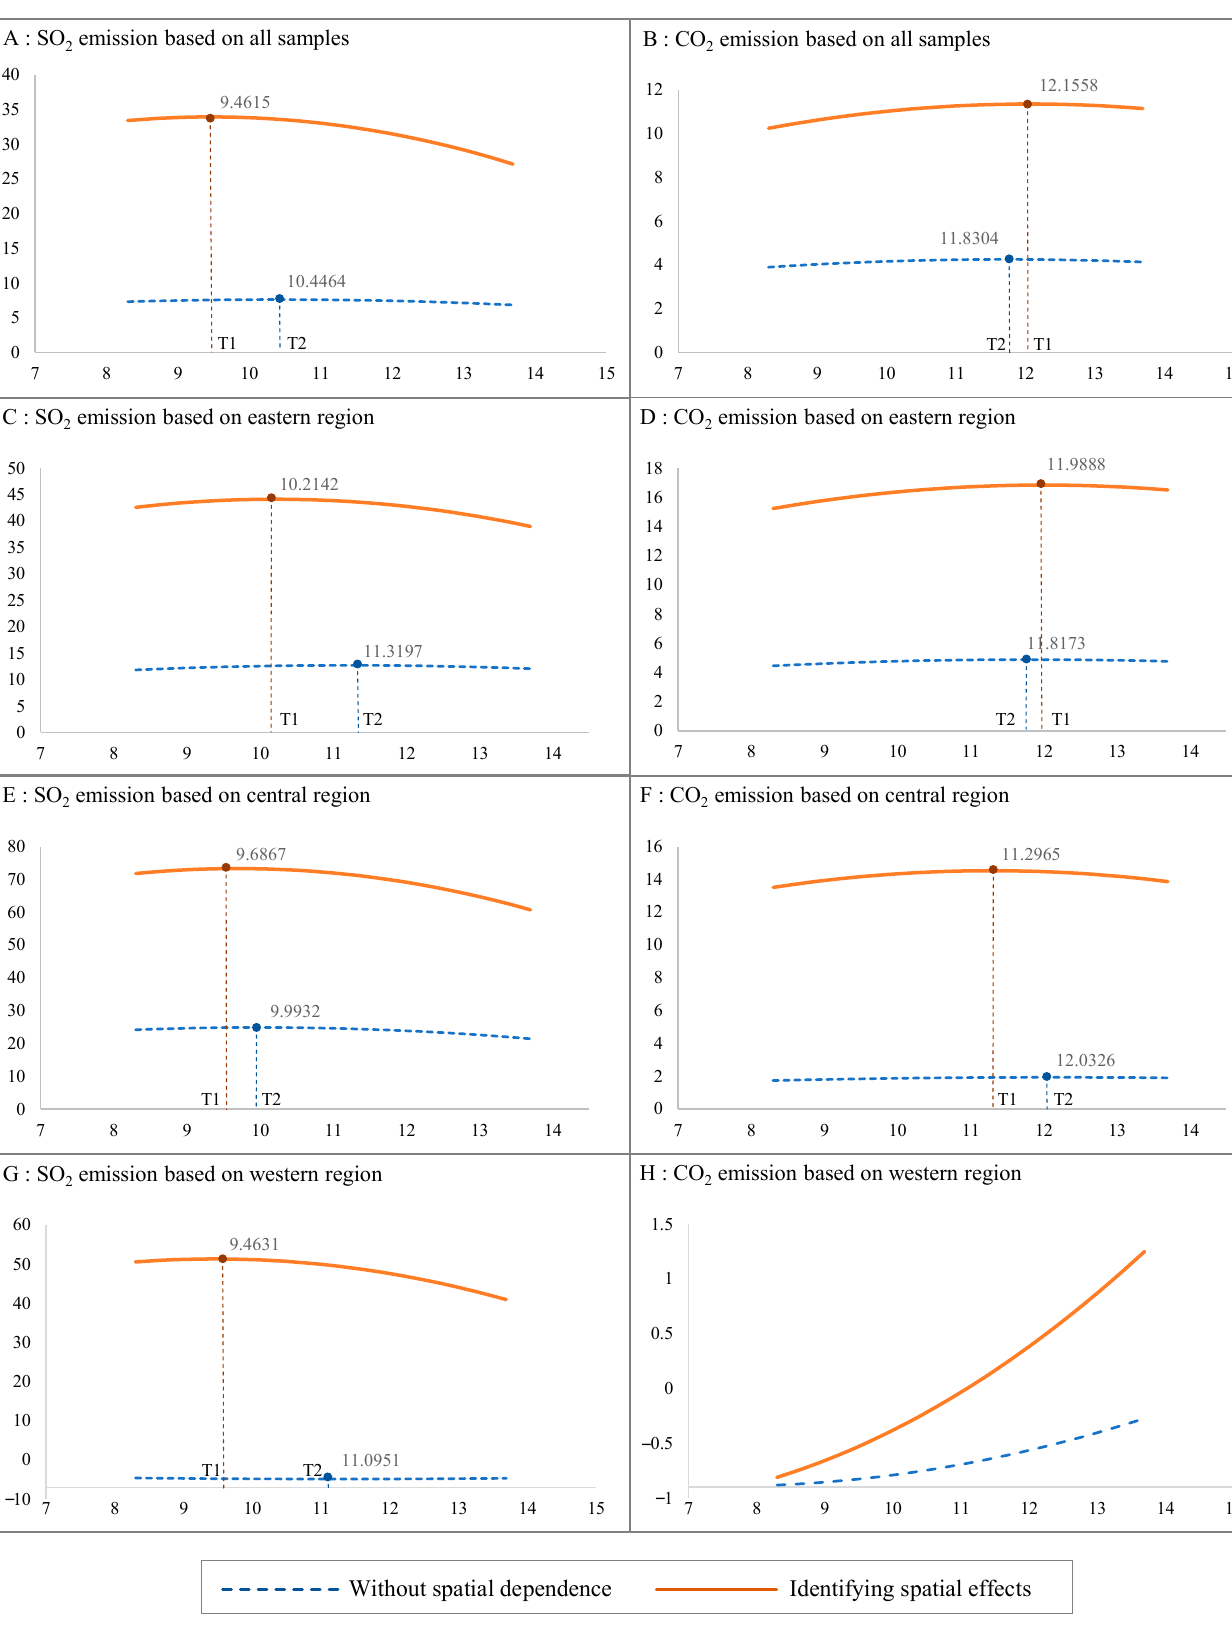
Figure 1. The EKC and its turning points with and without identifying spatial effects, based on different regional divisions.